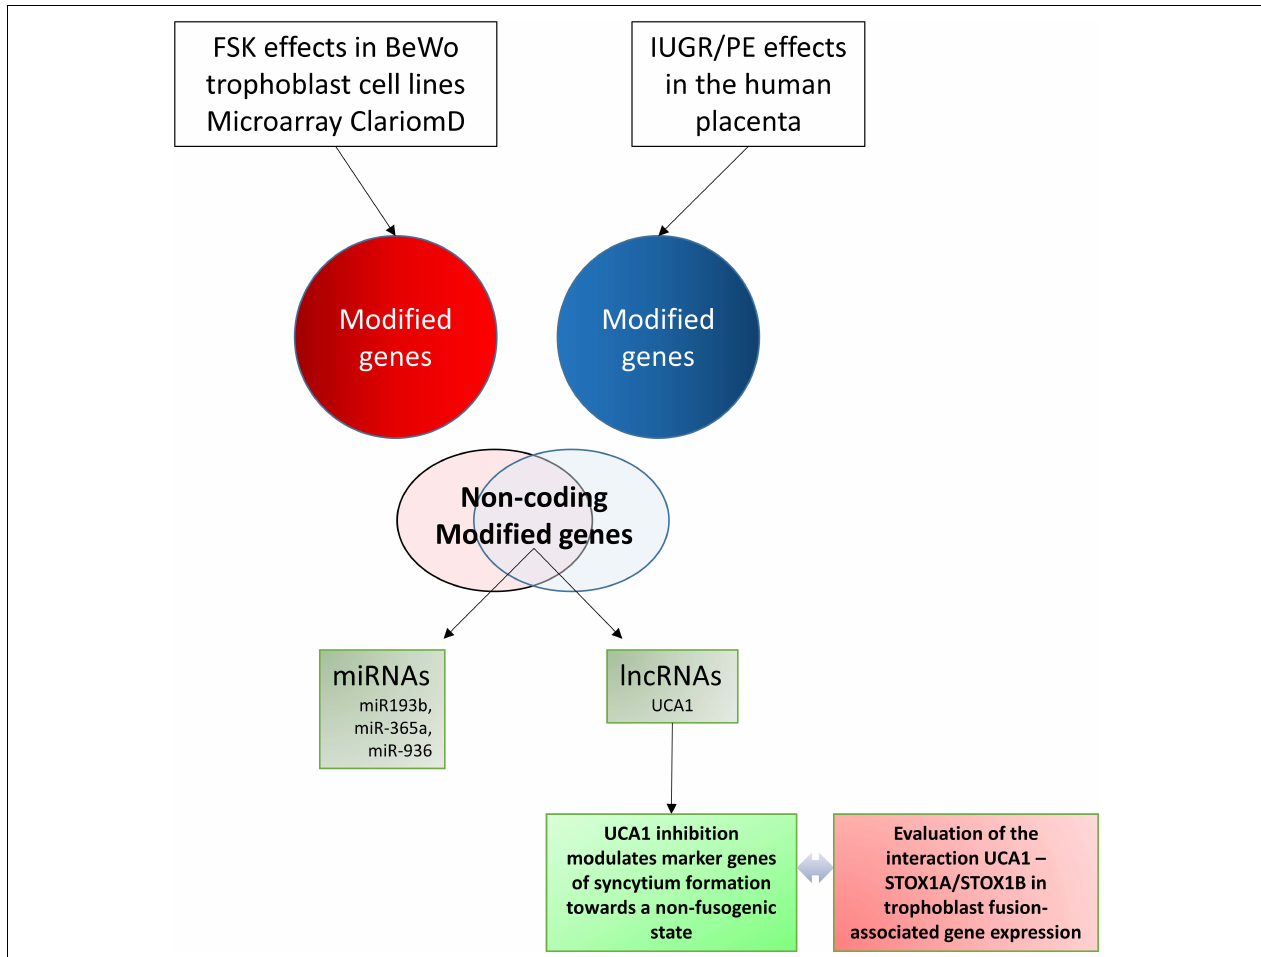
FIGURE 1 | Chart of the study, explaining the pivotal aim: connecting non-protein coding genes involved in trophoblast fusion with placental genes altered in human placental pathologies (Preeclampsia and Intra-Uterine Growth Restriction).